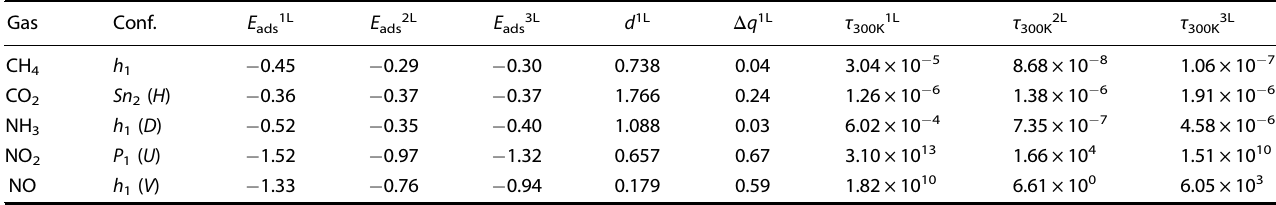
Table 1. Details on adsorption con fi guration, energies, and charge transfer, with corresponding recovery time at room temperature for all gas molecules on 1L, 2L, and 3L SnP 3 . Gas